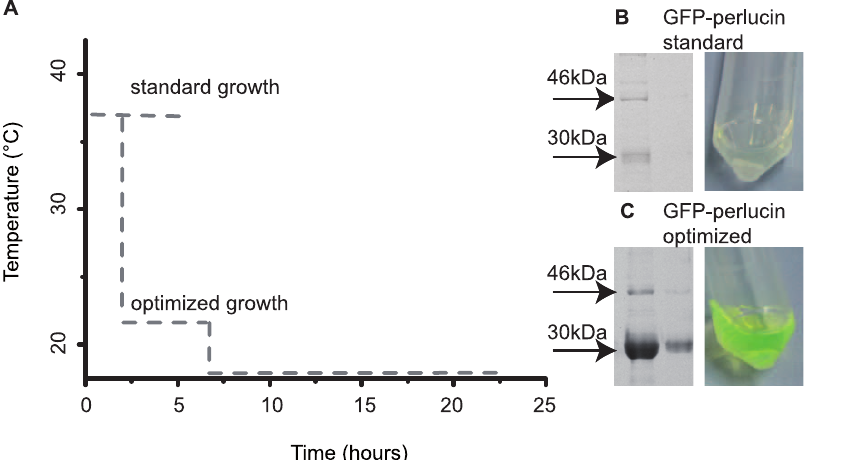
Figure 2. Culture conditions for native GFP-perlucin expression. (A) Temperature profile for two different growth conditions. (B) The native protein yield from cultures grown under standard conditions was low, inclusion bodies were favoured. (C) Optimized culture conditions yielded about 10 6 more soluble full length GFP-perlucin, (indicated by a mean value of 46 kDa) and about 100 6 more truncated GFP-perlucin (indicated by a mean value of 30 kDa) as quantified by coomassie gels. See for the exact molecular mass Figure 3 and for the molecular weight standard Supporting Information file Figure S1.